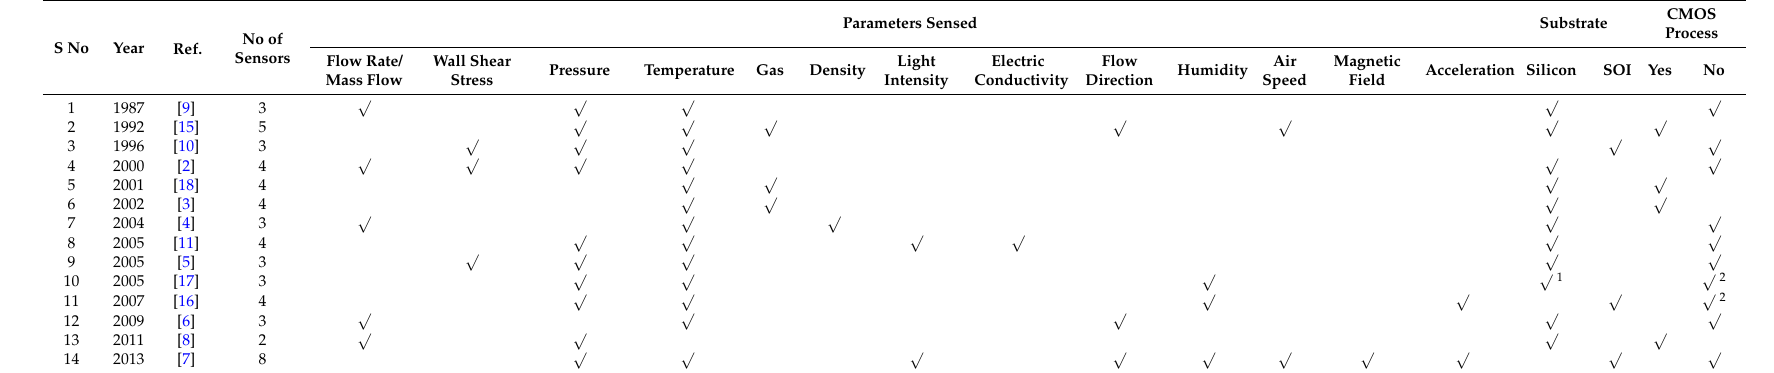
Table 1. Summary of the key multi-sensor MEMS chips reported in the literature since